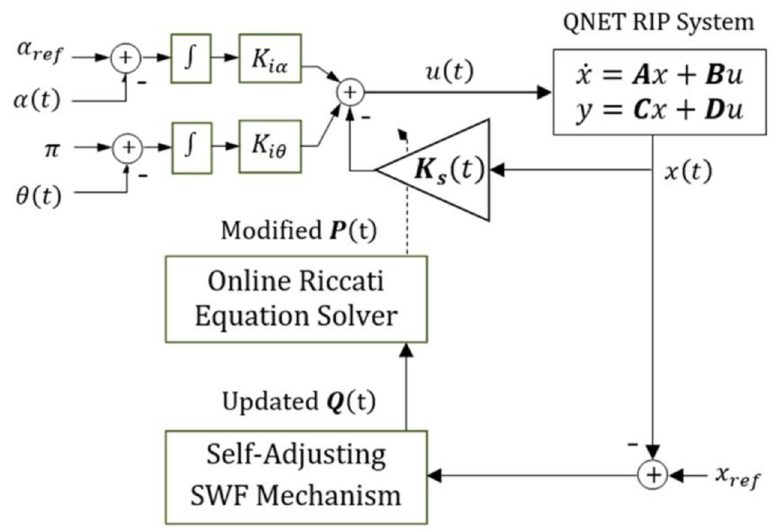
Fig 6. The block diagram of the ASWF-based STR